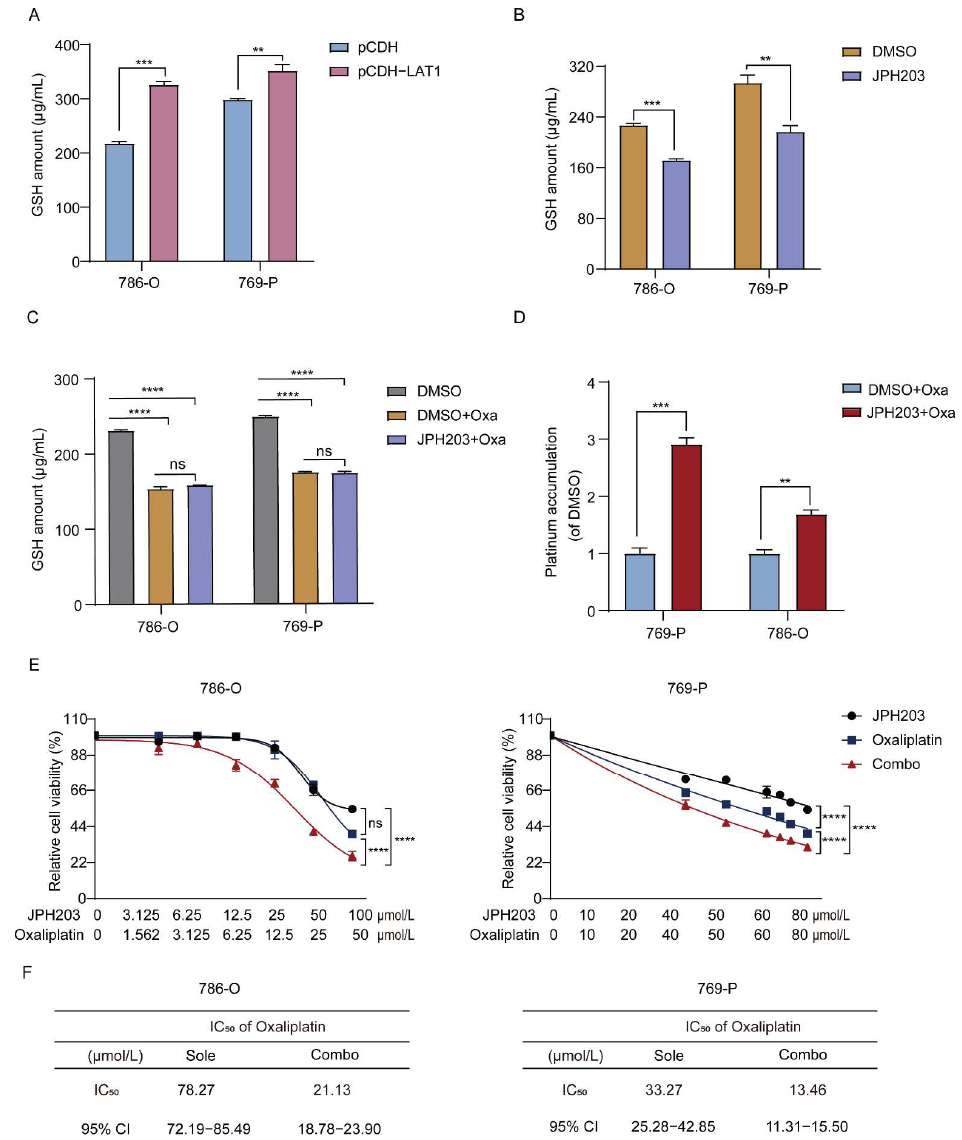
Figure 4. LAT1 inhibitor increases oxaliplatin accumulation via inhibiting GSH synthesis. ( A ) The amount of intracellular GSH in RCC cells (786-O and 769-P) with LAT1 overexpression (versus vector). ( B ) The amount of intracellular GSH in RCC cells (786-O and 769-P) after being treated with 10 µ mol/L JPH203 (versus DMSO). ( C ) The accumulation of GSH in RCC cells (786-O and 769-P) treated with oxaliplatin (0 and 50 µ mol/L) with and without JPH203 (10 µ mol/L). ( D ) Oxaliplatin accumulation was detected by ICP − MS in 786-O and 769-P cells treated with JPH203 (0 and 10 µ mol/L) for 48 h followed by adding 50 µ mol/L oxaliplatin for 48 h. ( E ) The cell viability of 786-O and 769-P cells treated with JPH203 with and without oxaliplatin. Combo—JPH203 in combination with oxaliplatin. ( F ) IC 50 values of oxaliplatin in RCC cells (769-P and 786-O) undergoing oxaliplatin alone or combination treatment. Oxa—oxaliplatin. Data are the mean ± SEM for biological triplicates. Students t -test (two-tailed), one-way ANOVA analysis, and two-way ANOVA analysis were used. ** p < 0.01; *** p < 0.001; **** p < 0.0001. ns—no